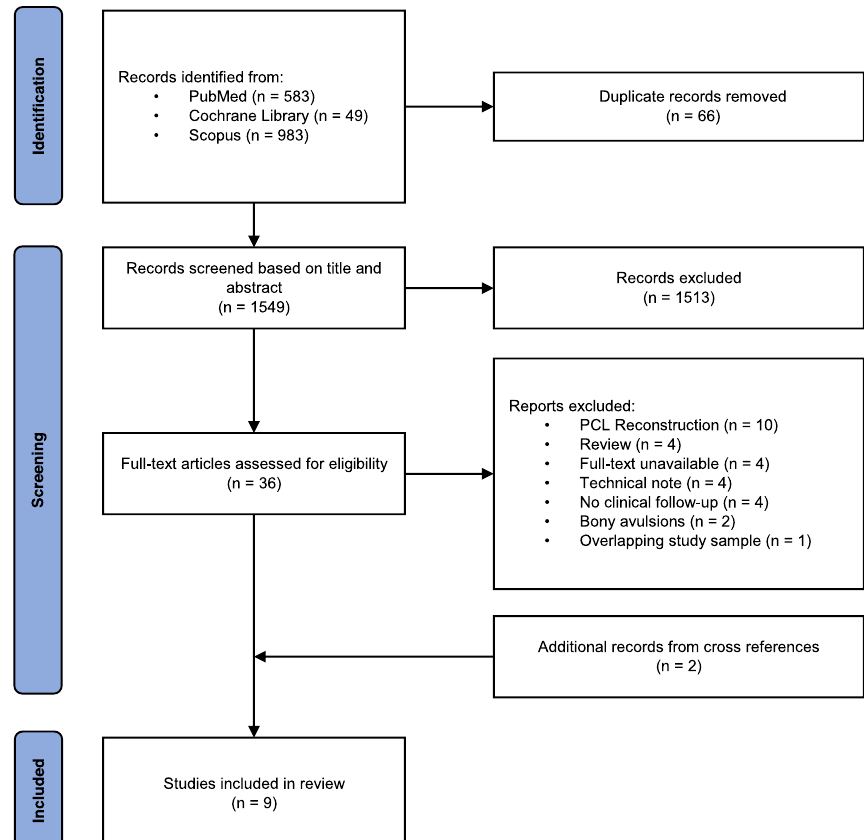
Fig. 1 PRISMA flowchart describing the inclusion process of relevant